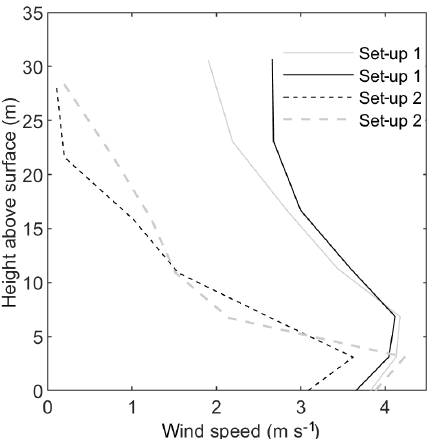
Figure 13. Near-surface profiles of wind speed for set-up 1 (solid line) and set-up 2 (dashed line) above the Ice Chapel surface. Grey lines show profiles at locations further downwind.